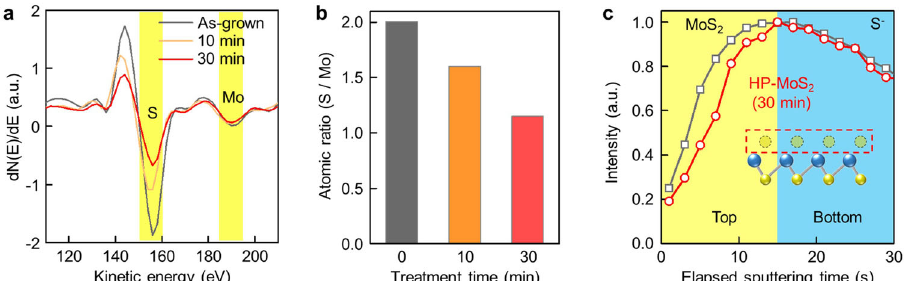
Fig. 3 Chemical composition of MoS 2 after desulfurization. a Differential energy distribution spectra of Auger electrons detected from MoS 2 and HP- MoS 2 . b The atomic ratio of sulfur-to-molybdenum within samples. c ToF-SIMS depth pro fi le of sulfur ion achieved from MoS 2 and HP-MoS 2 . Inset shows the atomic structure of MoS 2 after removing top-sulfur layer.